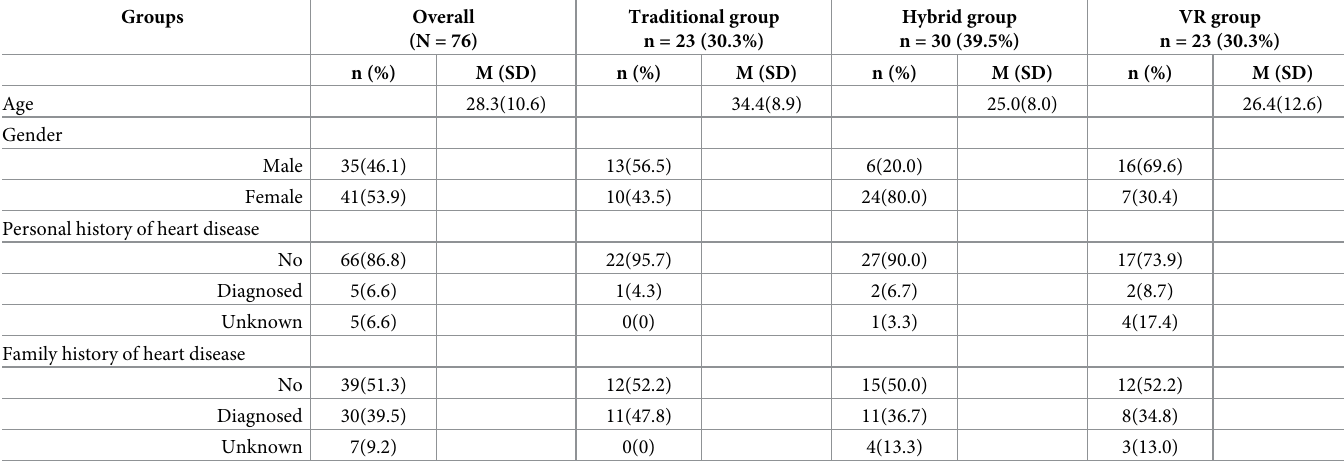
Table 1. Descriptive analysis of participants background between